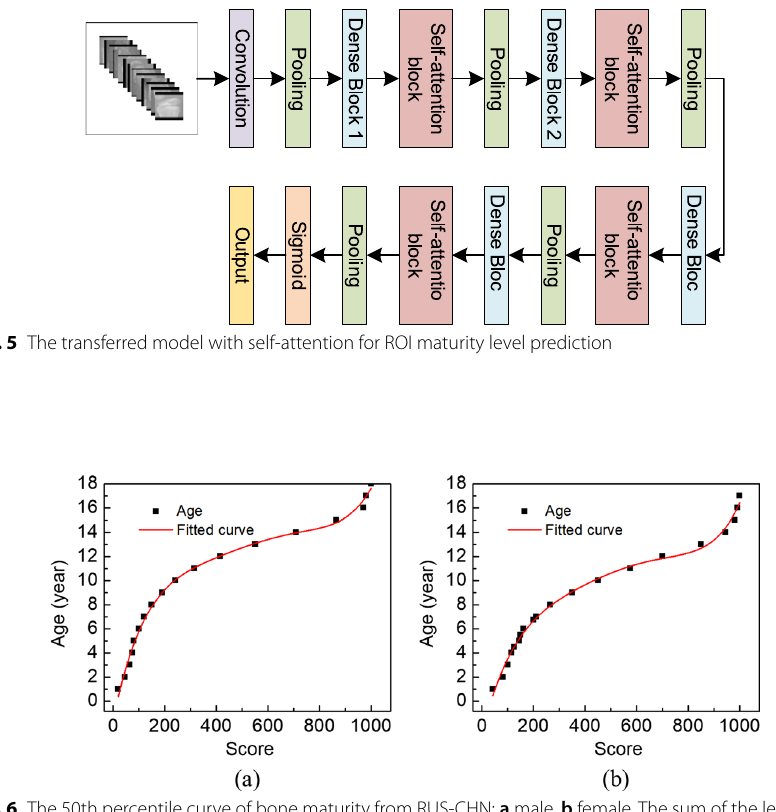
Fig. 6 The 50th percentile curve of bone maturity from RUS-CHN: a male, b female. The sum of the levels